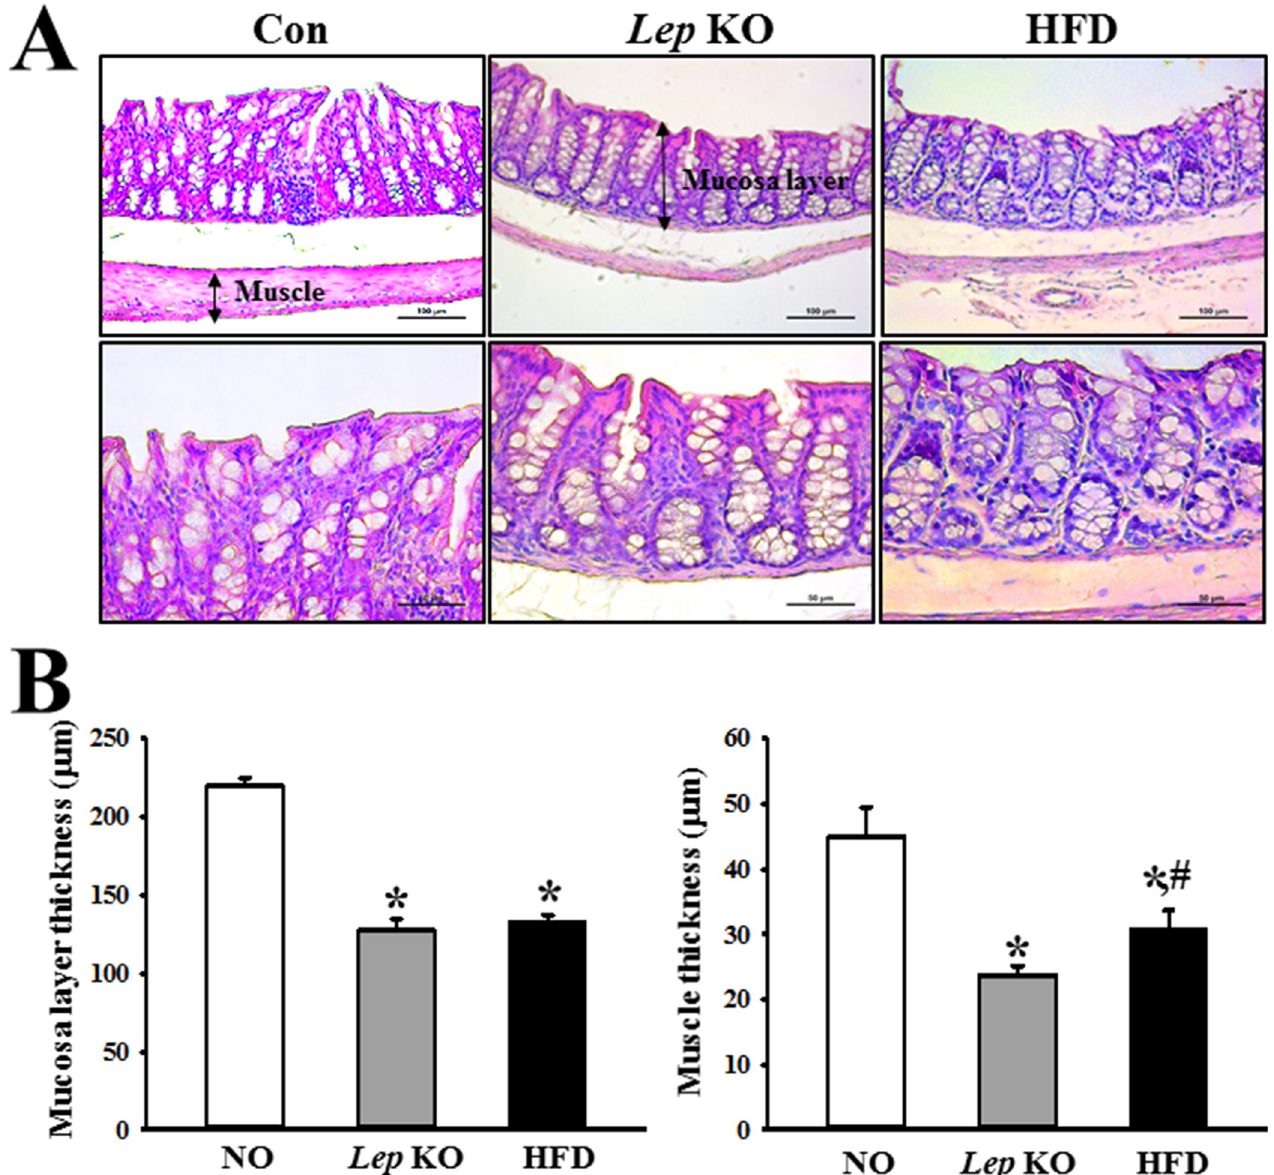
Fig 4. Histological structures of the mid colon. (A) Histological structures of the hematoxylin and eosin (H&E)-stained mid colon. H&E-stained sections of the mid colon from the Lep KO mice and HFD-treated mice were observed at 100 × and 400 × magnification using an optical microscope. (B) The thickness of the mucosal layer and muscle. The histopathological parameters were determined using the Leica Application Suite (Leica Microsystems). Three to five mices per group were used for histological analysis, and each parameter was measured in duplicate on two different slides. The data are reported as the mean ± SD. � indicates p < 0.05 compared to the Con group. Abbreviations: Con, Control group; Lep KO, Leptin knockout mice; HFD, High fat